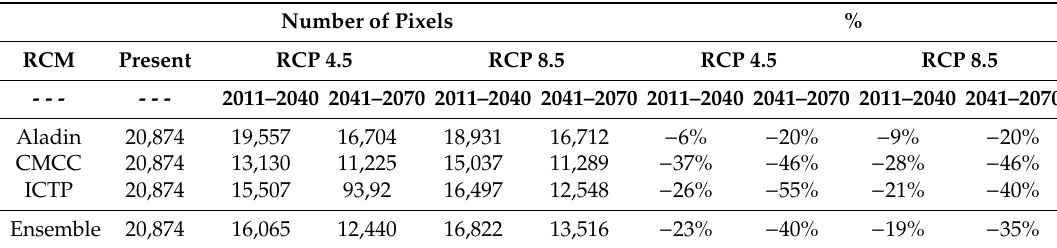
Table 3. Current Alpine occurrence (in terms of number of pixels, i.e., 100 ha wide each) of unclassified pasturelands and expected changes (%) of suitability under future climate conditions, as reported by the three regional circulation models (RCMs) and their ensemble, time slices (2011–2070 and 2071–2100), and RCP scenarios (4.5 and